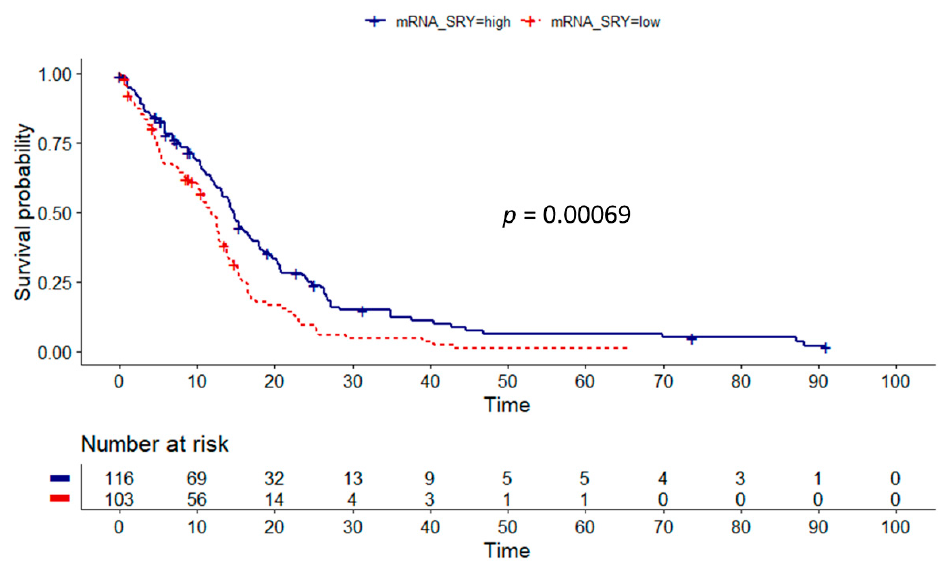
Figure 4. Kaplan–Meier log-rank survival analysis of low versus high SRY expressing GBM tumors ( n = 219). Cut-off value was estimated via maximally selected rank statistics analysis (Supplementary Materials, Figure S2). Decreased gene expression correlates with shorter OS (11.9 vs. 14.7 months).